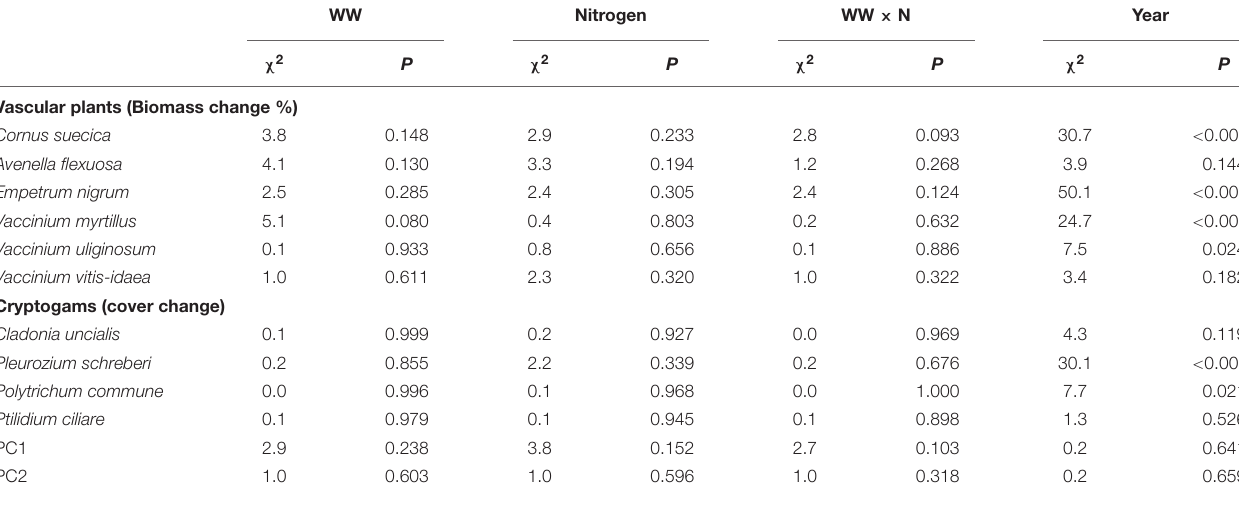
WW Nitrogen WW × N